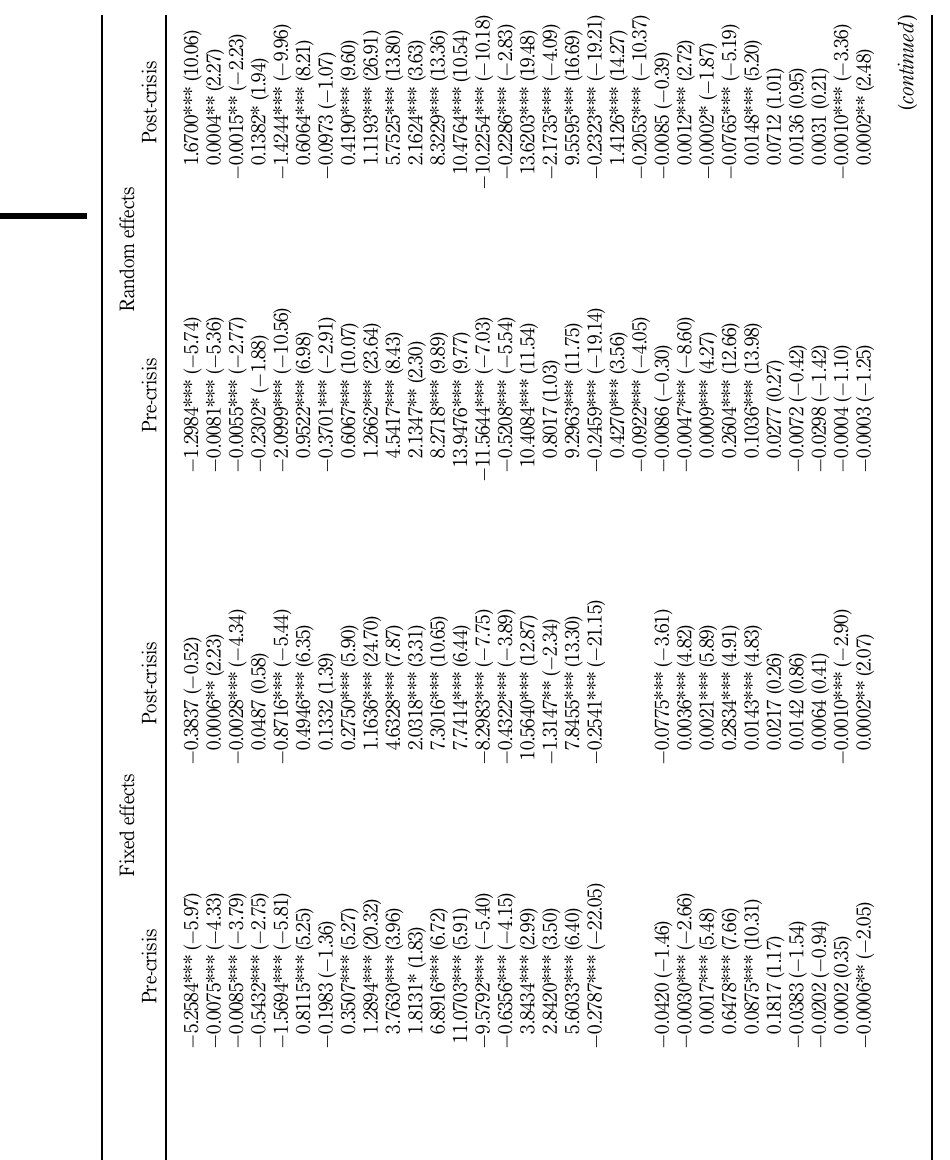
Table 6. Robustness checks with panel data